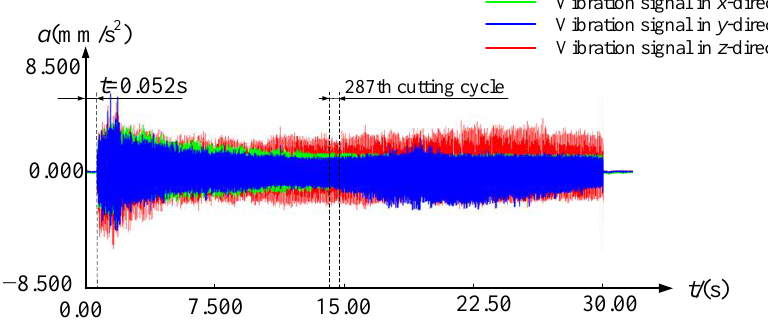
Figure 5. Experimental cutting vibration acceleration signals for scheme 1.